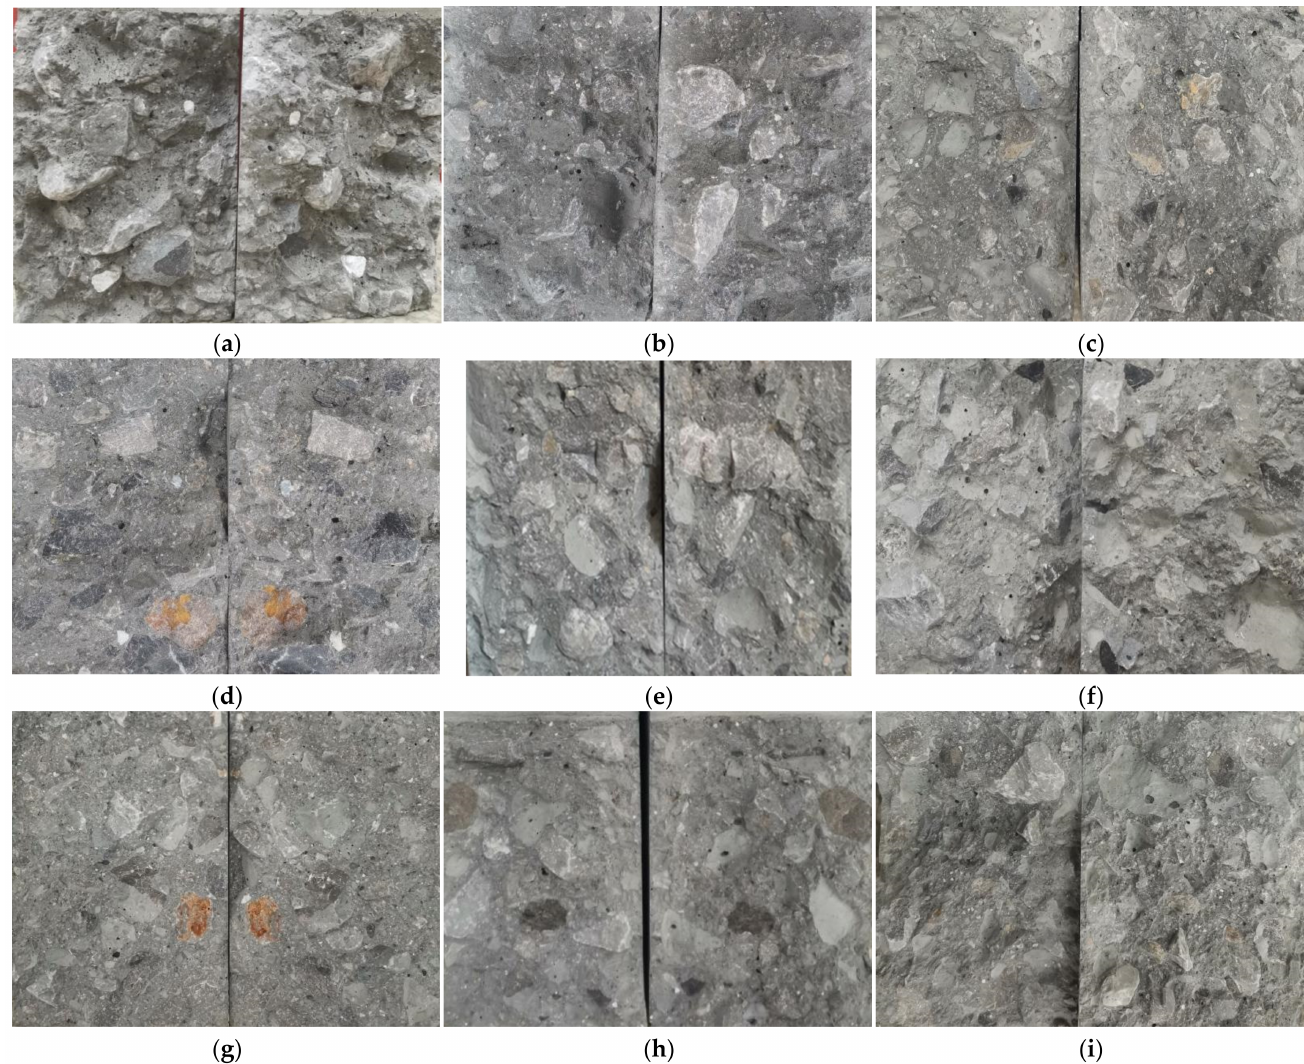
Figure 9. Fracture surfaces of wedge-splitting specimens at different ages and under different curing conditions: ( a ) T = 20 ◦ C, RH = 98%, Age = 7 days; ( b ) T = 20 ◦ C, RH = 98%, Age = 14 days; ( c ) T = 20 ◦ C, RH = 98%, Age = 28 days; ( d ) T = 20 ◦ C, RH = 98%, Age = 60 days; ( e ) T = 20 ◦ C, RH = 98%, Age = 90 days; ( f ) T = 10 ◦ C, RH = 98%, Age = 28 days; ( g ) T = 40 ◦ C, RH = 98%, Age = 28 days; ( h ) T = 20 ◦ C, RH = 60%, Age = 28 days; ( i ) T = 20 ◦ C, RH = 60%, Age = 28